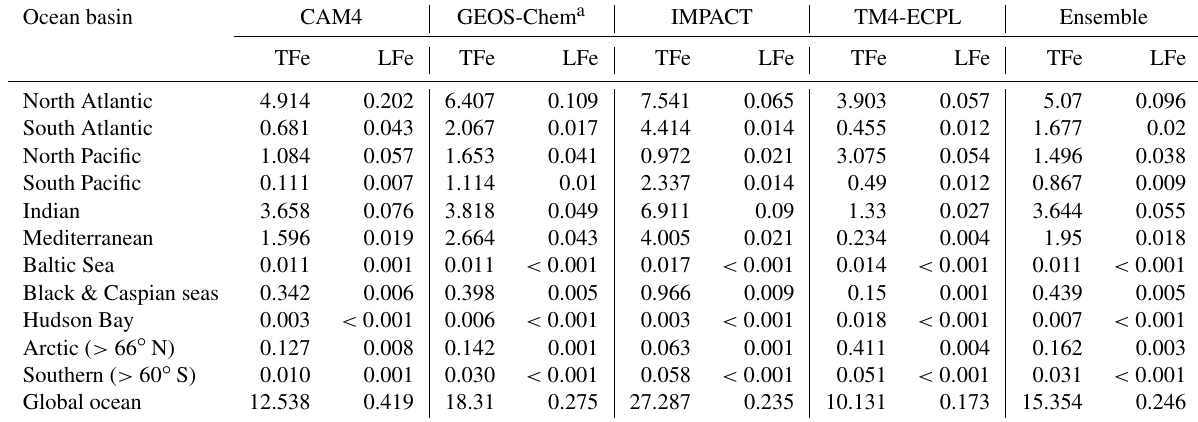
Table 5. Annual deposition fluxes (TgFeyr − 1 ) to different ocean basins of total (TFe) and labile (LFe) Fe, as calculated by the contributing models and the derived ensemble